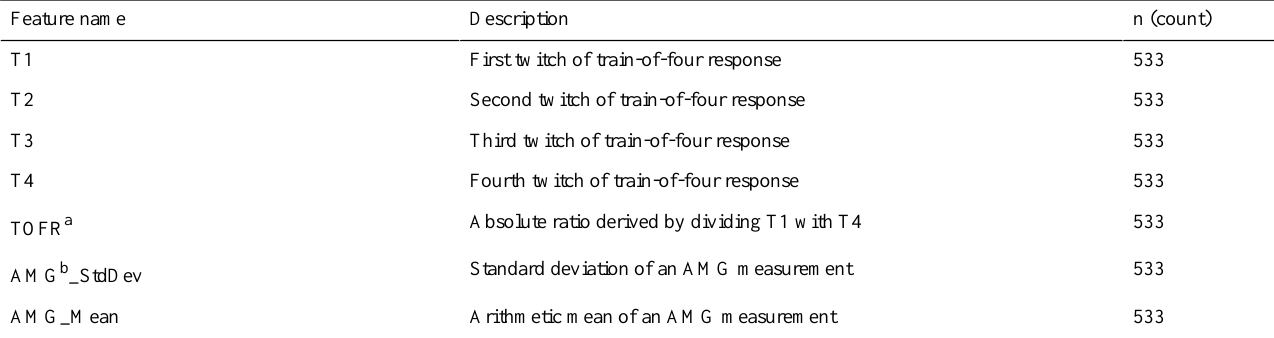
Table 1. Description of the basic features of data set. A train-of-four recording is defined as the integral combination of all acceleration/angulation points of T1, T2, T3, and